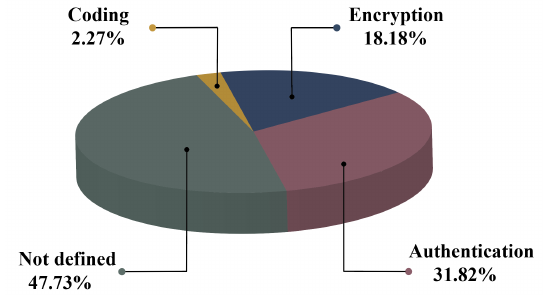
Figure 13. Security